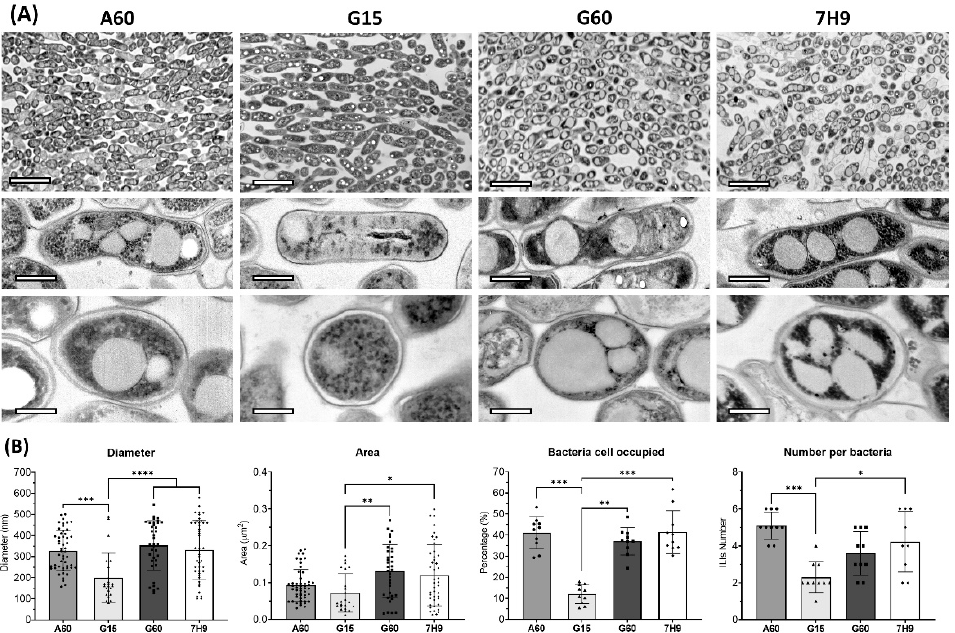
Figure 2. ( A ) TEM representative micrographs of M. brumae pellicles developed in different culture media. General perspective and detail of the bacilli in longitudinal and transversal perspective, scale bars correspond to 2 µm, 500 nm, and 250 nm, respectively. ( B ) ILI characterization by quantifying different parameters: diameter, area, percentage of bacteria occupied, and number of ILIs per bacterium using ImageJ version 1.53 (National Institutes of Health, MD, USA) scientific images software. TEM micrographs of ten longitudinally cut bacilli were selected for measurements ( n = 10), data presented as mean values ± SD statistical analysis using non-parametric multiple comparisons Kruskal-Wallis test, * p < 0.05, ** p < 0.01, *** p < 0.001, **** p < 0.0001. Sauton A60, G15 and G60 media, or Middlebrook 7H9 medium were used to culture mycobacteria. A60 is Sauton containing L-asparagine and 60 mL/L of glycerol (6% v / v ). Sauton G15 and G60 contained L-glutamate and 15 or 60 mL/L of glycerol (1.5% and 6% v / v ), respectively.